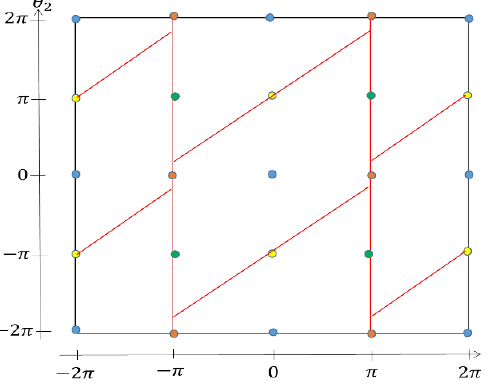
Figure 7 . Schematic plot of the phase diagram in the limit (cid:3) 1 (cid:29) M; (cid:3) 2